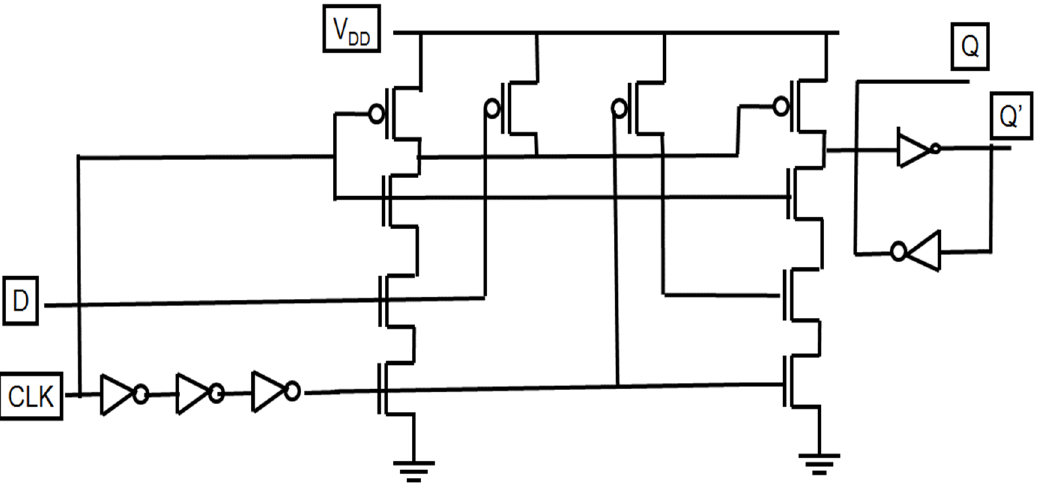
Figure 9. Schematic of the hybrid-latch flip-flop (HLFF).